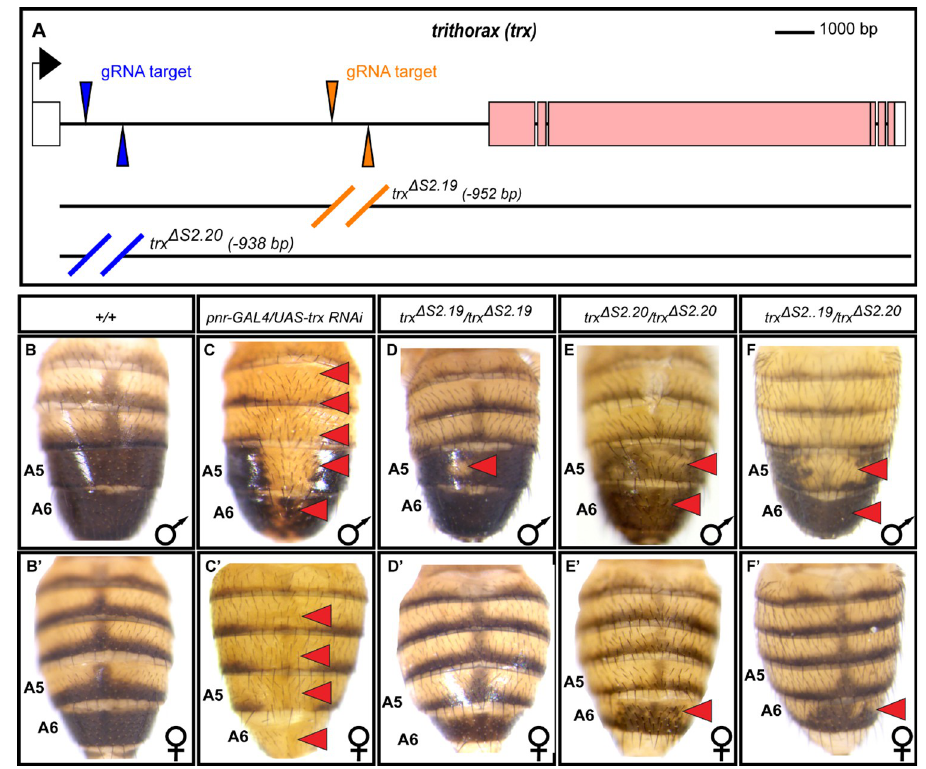
Fig 5. trithorax function and its intronic CREs are necessary for the D . melanogaster pigmentation pattern. (A) To-scale annotated representation of the trithorax locus. Black arrow indicates the site and direction of transcription initiation. Exons are the large rectangles, and those coding for the Trx protein are colored pink. The position of the S2 . 19 and S2 . 20 pCREs each lie between a pair of guide RNA (gRNA) target sites that were used to create the CRE deletion alleles by CRISPR/Cas9-mediated genome editing. The wild type pattern of (B) male and (B’) female tergite pigmentation from the w 1118 stock. Suppression of trx expression in the dorsal midline region by RNA interference (RNAi) resulted in lost tergite pigmentation in (C) males and (C’) females. When the S2 . 19 sequence was deleted (D) tergite pigmentation was reduced in the male A5 segment, whereas (D’) female pigmentation appeared wild type. When the S2 . 20 sequence was deleted, (E) tergite pigmentation was reduced on the male A5 segment tergite and to a lesser extent in the A6 segment, while in females (E’) A6 tergite pigmentation was subtly reduced. In trx trans - heterozygous (F) males and (F’) females, tergite pigmentation is further reduced in the male A5 tergite, and subtly in the male and female A6 tergites. Red arrowheads point to tergites that have reduced melanic pigmentation compared to the wild type ( +/+ )